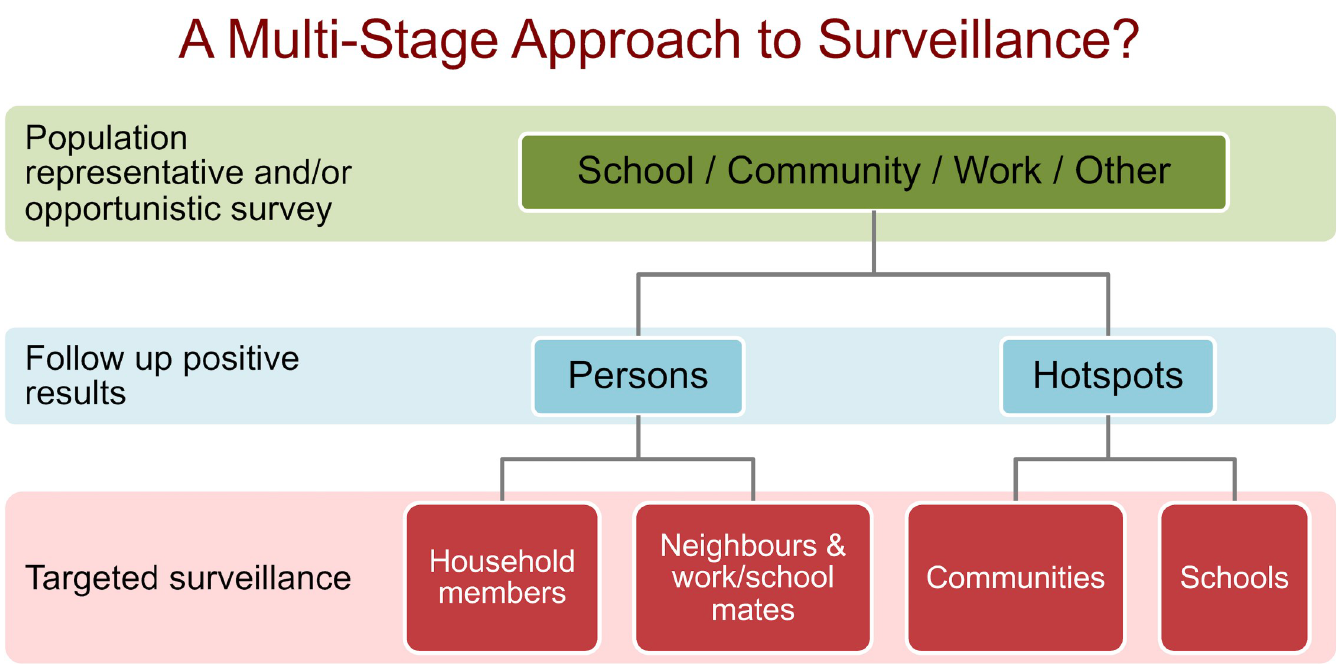
Fig 12. Potential framework for a multi-stage surveillance strategy for LF elimination